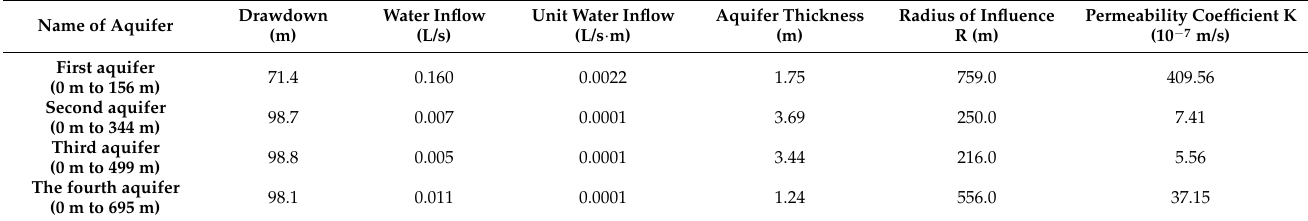
Table 2. Hydrogeological